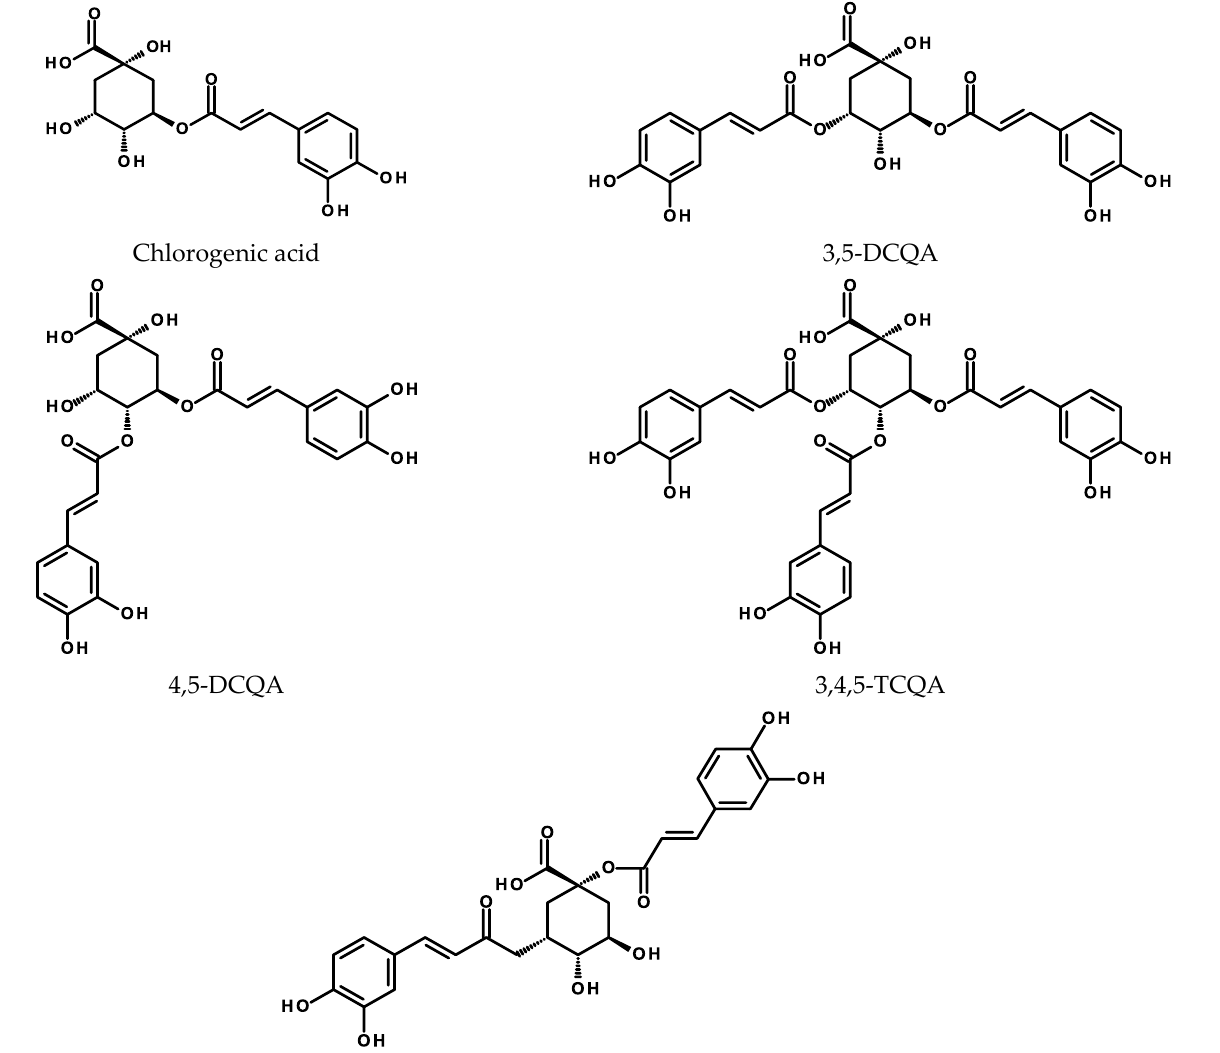
Figure 4. Chemical structures of selected acylquinic acids (CGAs).